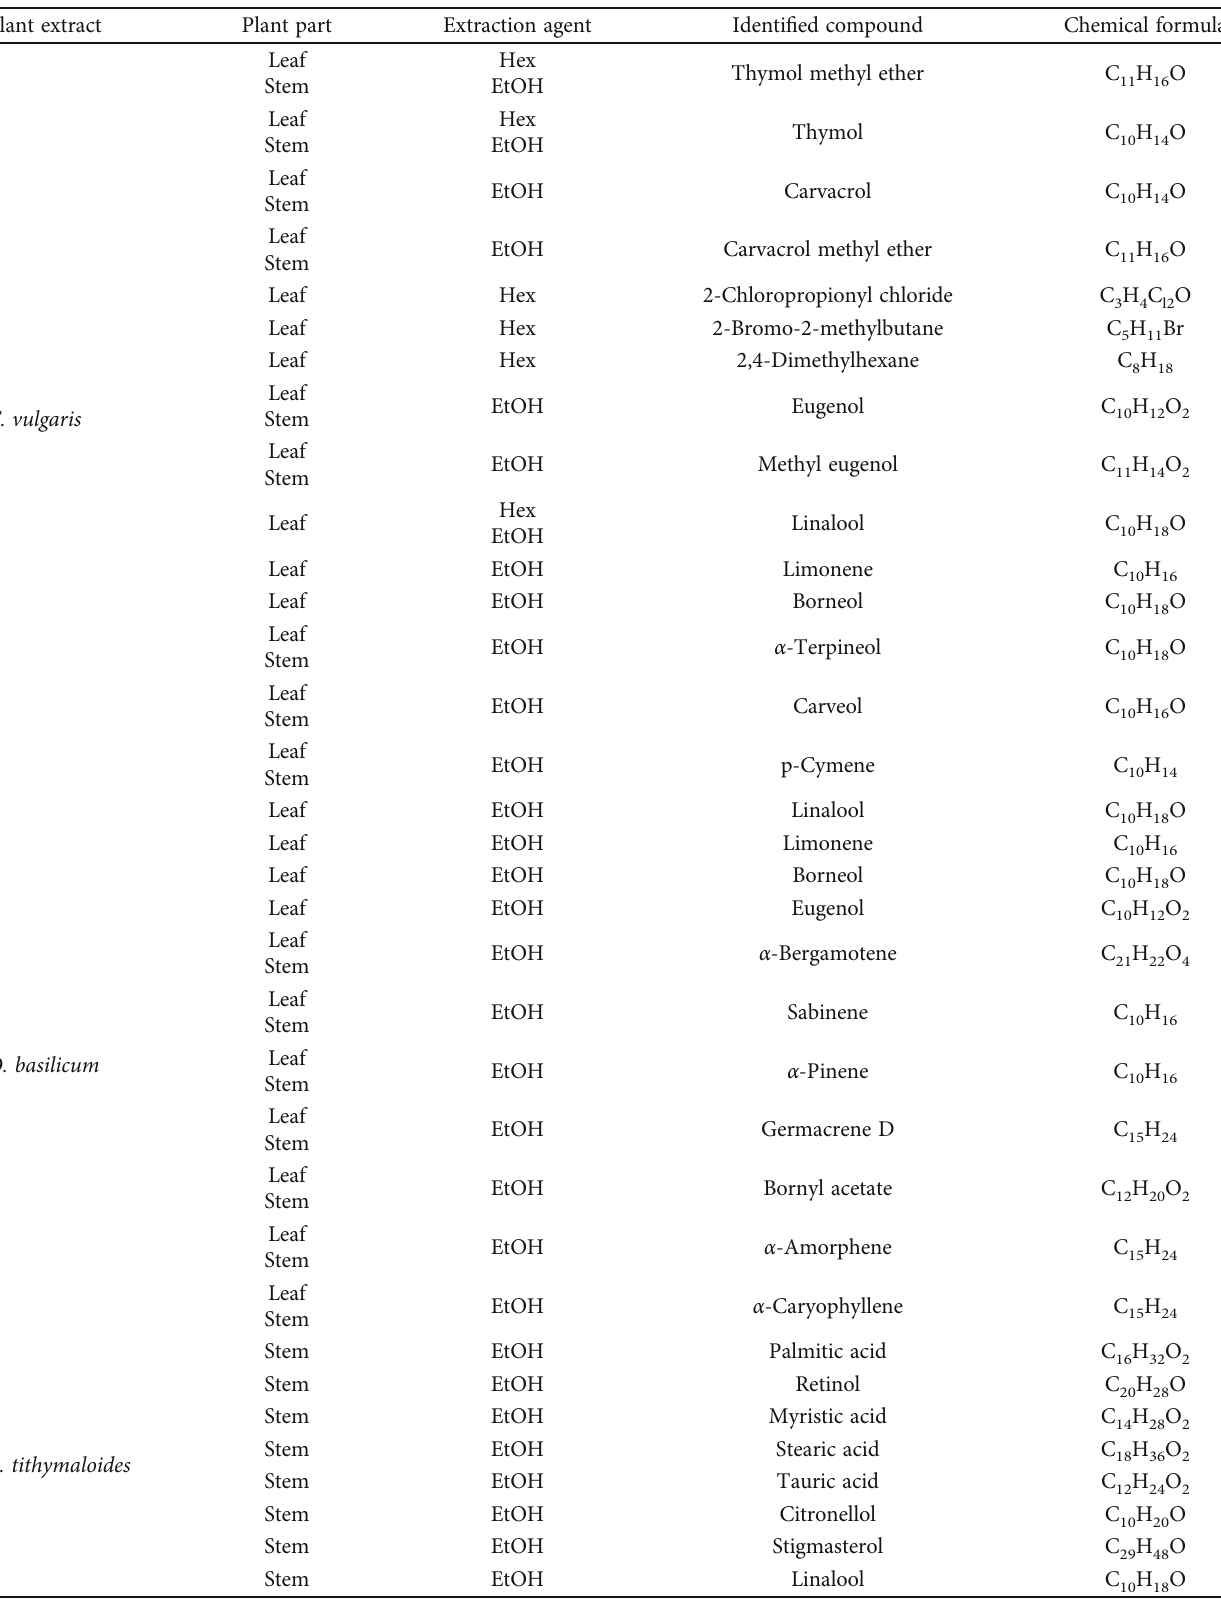
Table 1: Chemical compounds potentially responsible for the antifungal activity present in the plant